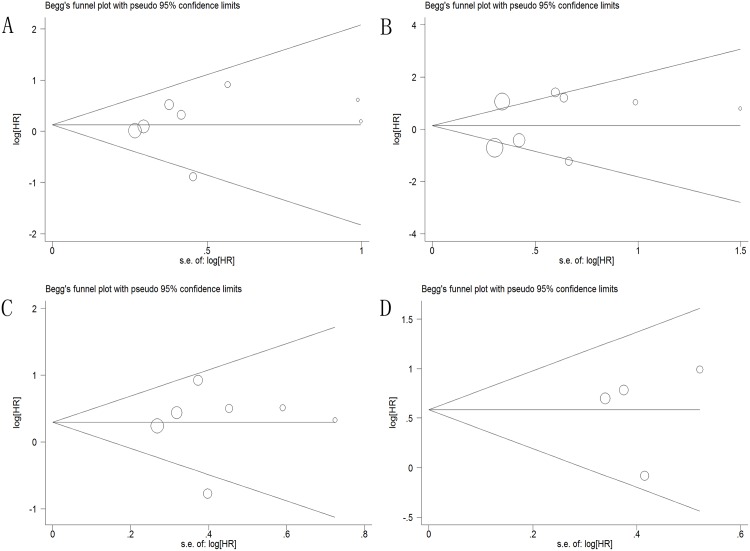
Begg’s funnel plots of the publication bias.Begg’s funnel plots of the publication bias for overall merged analysis of OS or DFS/RFS. Each point represents a separate study. About the OS analysis, (A) and (B) represents group 1 and group 2 respectively. About the DFS/RFS analysis, (C) and (D) represents group 1 and group 3 respectively.